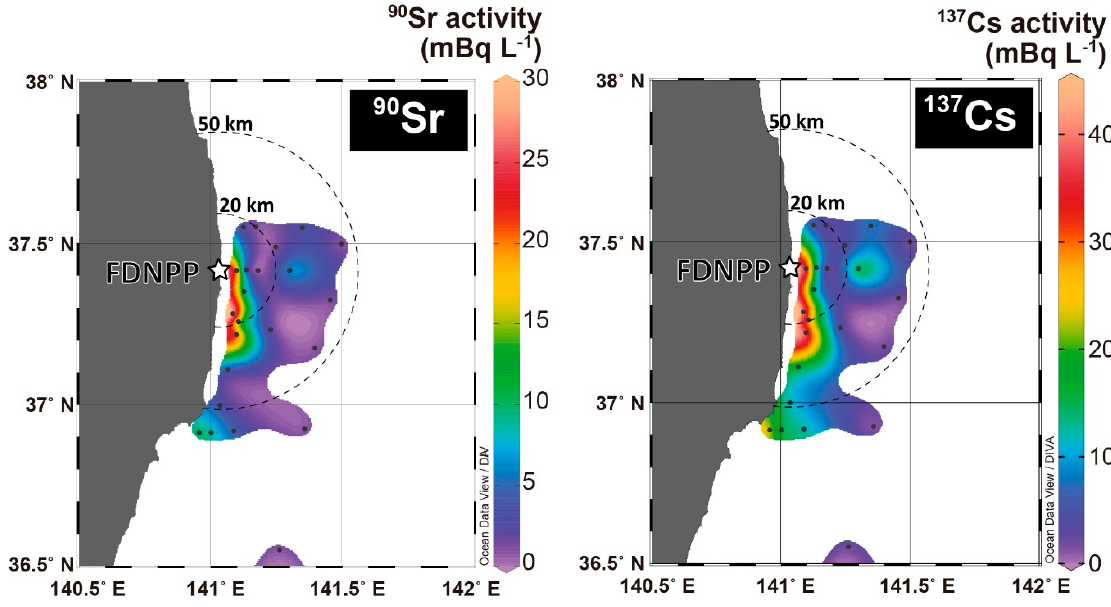
Figure 3. Distribution of 90 Sr and 137 Cs activities in surface seawater collected in May 2013.